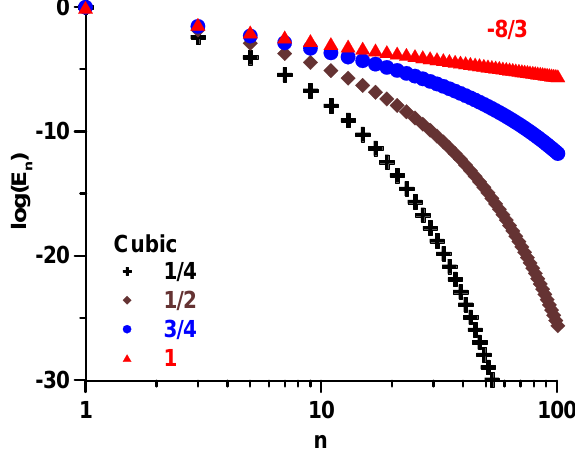
Fig. 6. Energy spectra | S n /A | 2 of a Riemann wave in purely Figure 6. Energy spectra (|S n /A| 2 of Riemann wave in purely quadratic nonlinear medium. Time Fig. 7. Energy spectra of a Riemann wave in purely cubic nonlinear quadratic nonlinear medium. Time is normalized on T 2 . Figure 7. Energy spectra of Riemann wave in purely cubic nonlinear medium. Time is is normalized on T 2 . . medium. Time is normalized on T 3 normalized on T 3 accordingly.